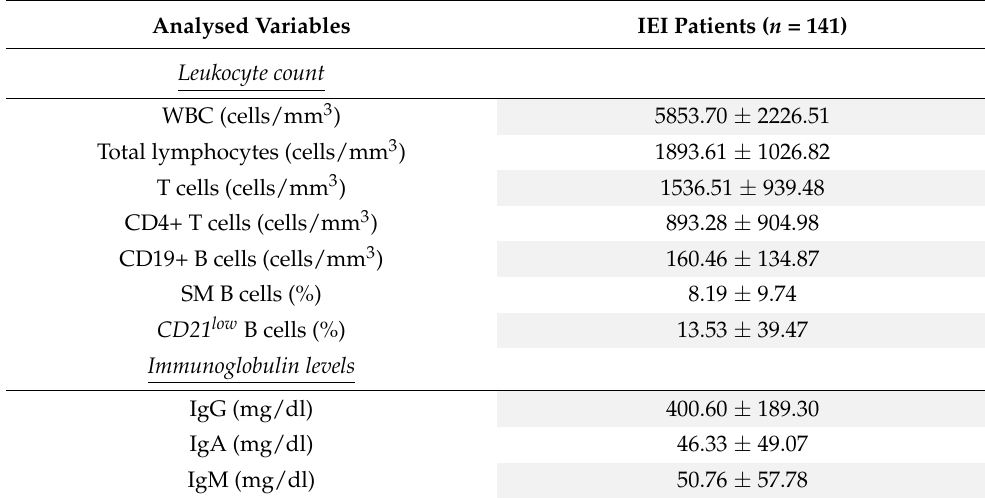
Table 3—IEI = inborn errors of immunity, WBC = white blood cells; SM B cells = switched memory B cells; IgG = immunoglobulin G; IgA= immunoglobulin A; IgM = immunoglobulin